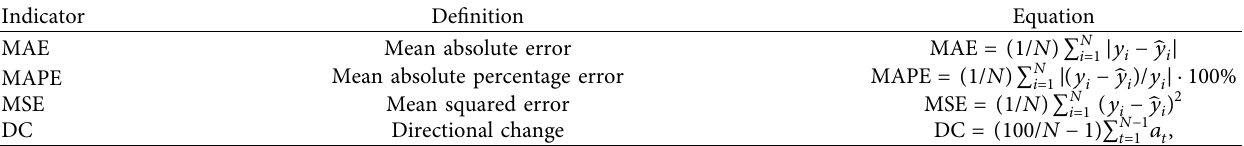
Table 2: Four point prediction evaluation metrics.